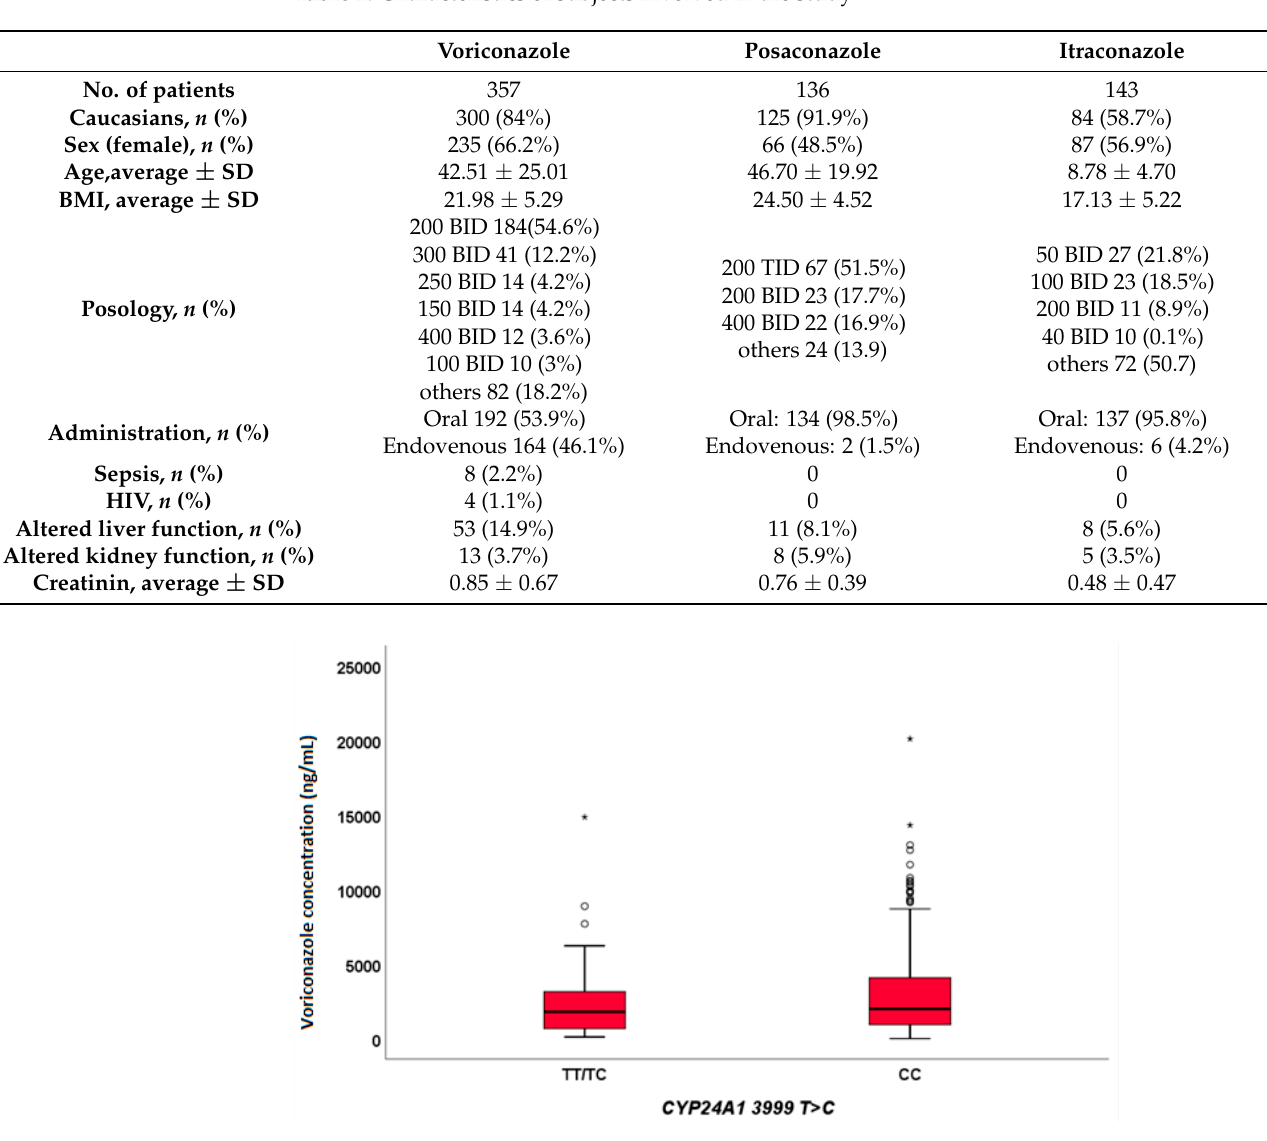
Table 2. Linear regression analysis: factors able to predict voriconazole plasma concentrations over efficacy cut-off limits (>1000 ng/mL) and toxicity cut-off limits (>5000 ng/mL). Bold characters represent statistically significant values.